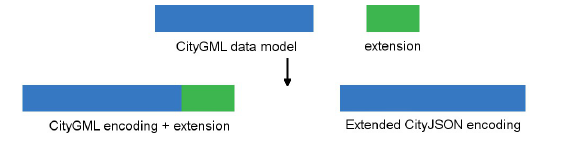
Figure 1. Extensions of the